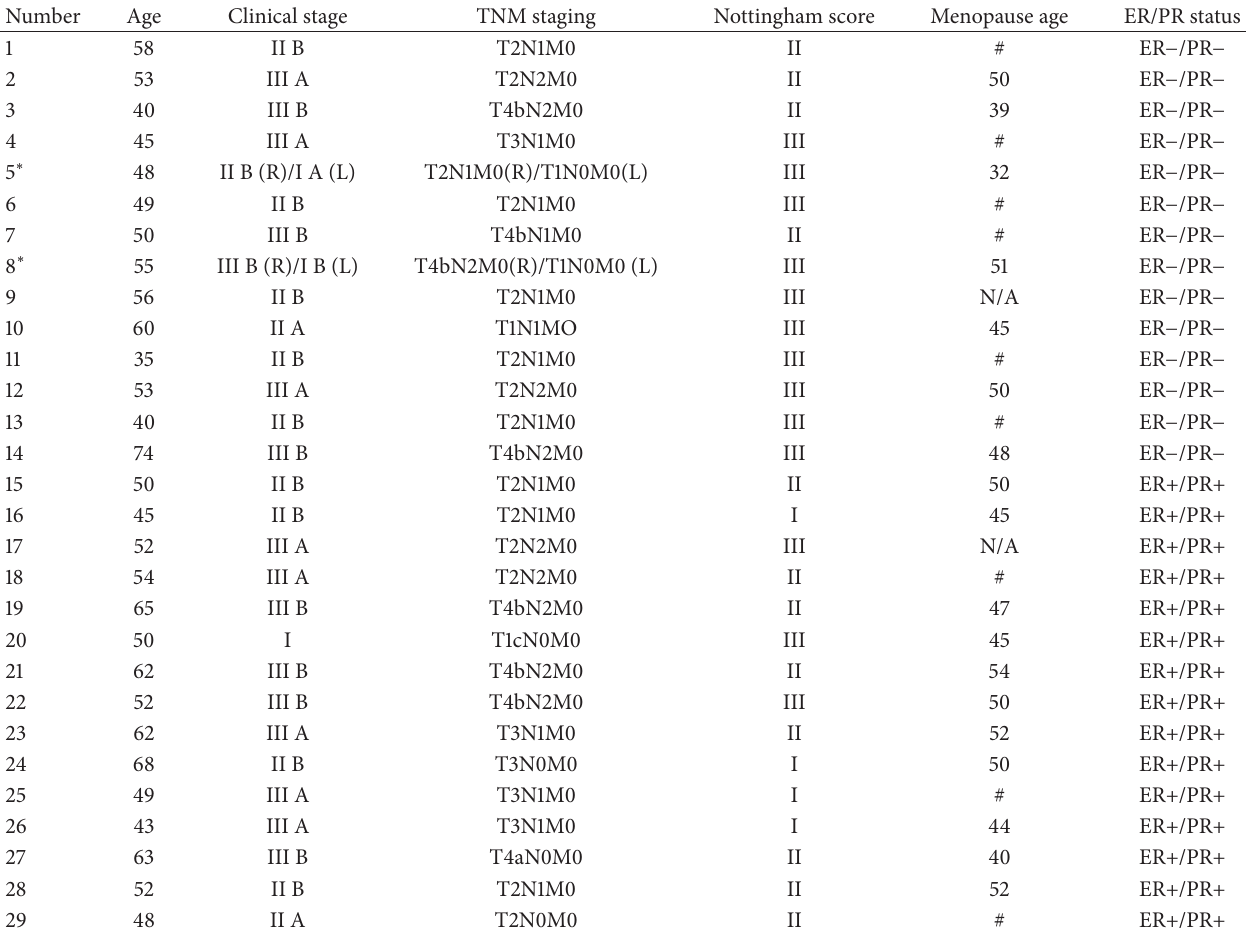
Table 1: Baseline clinical and histological characteristics of the HER2 −